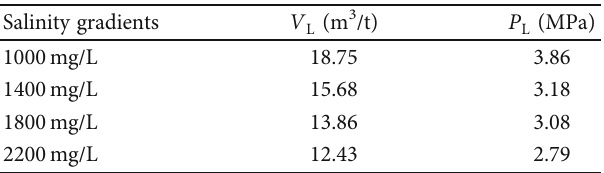
Figure 2: Methane isothermal adsorption/desorption curves of coal samples with di ff erent salinity. Table 3: Langmuir isothermal adsorption parameters of Baode coal samples with di ff erent